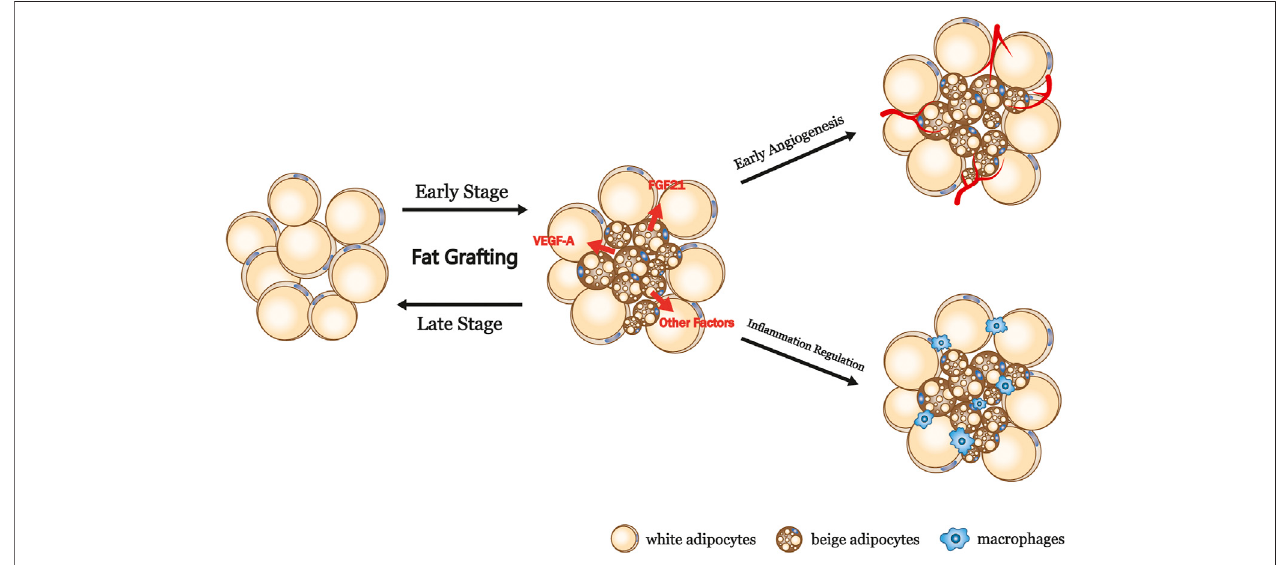
FIGURE6| Summaryandproposedmodelofthebrowningprocessinfatgrafts.VEGF-A,vascularendothelialgrowthfactorA;FGF21, fi broblastgrowthfactor21.